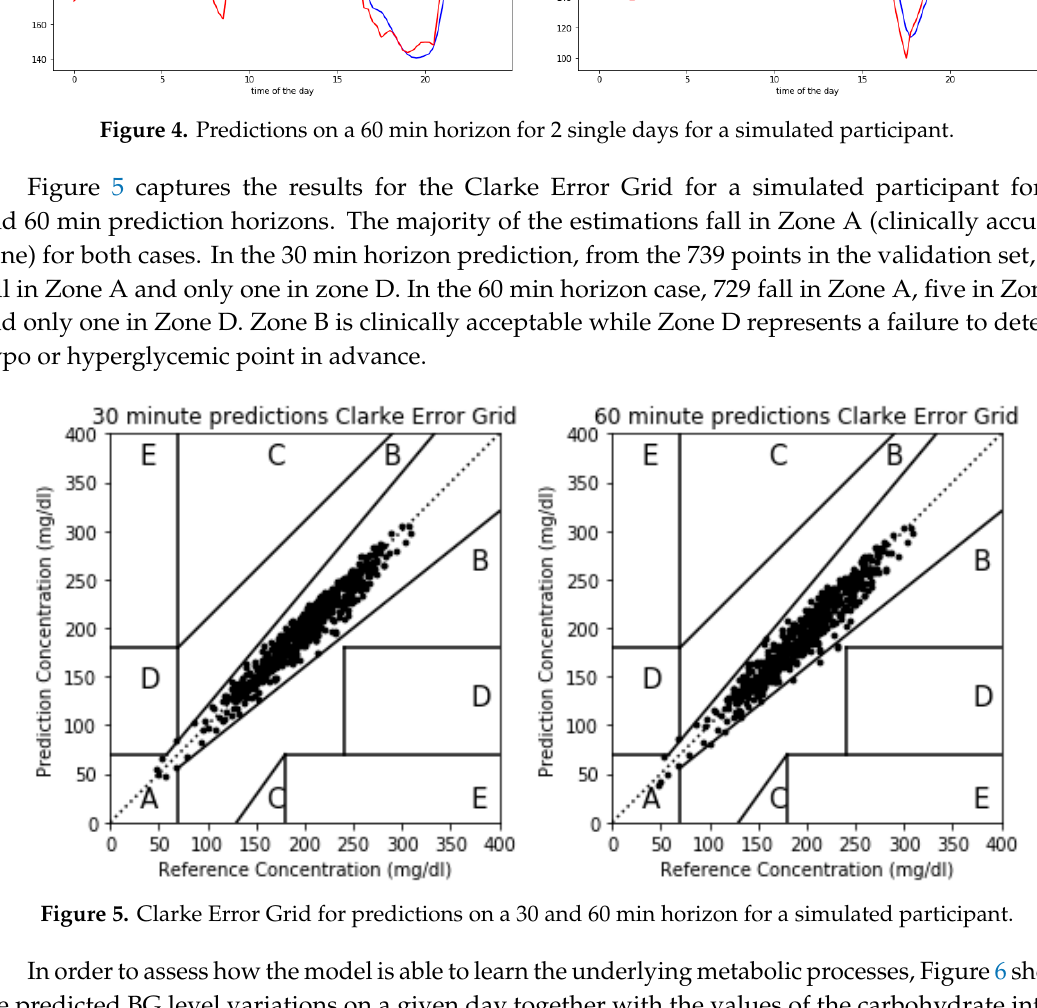
Figure 4. Predictions on a 60 min horizon for 2 single days for a simulated participant.